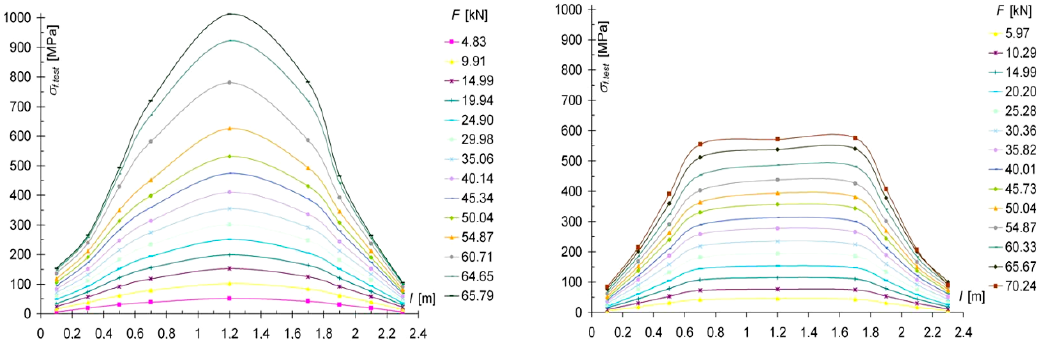
Figure 13. Comparison σ f.test —l of stress distribution in the CFRP tape for the SW-2.4S / 1 ( a ) and the SW-2.4S / 4 ( b ) models.